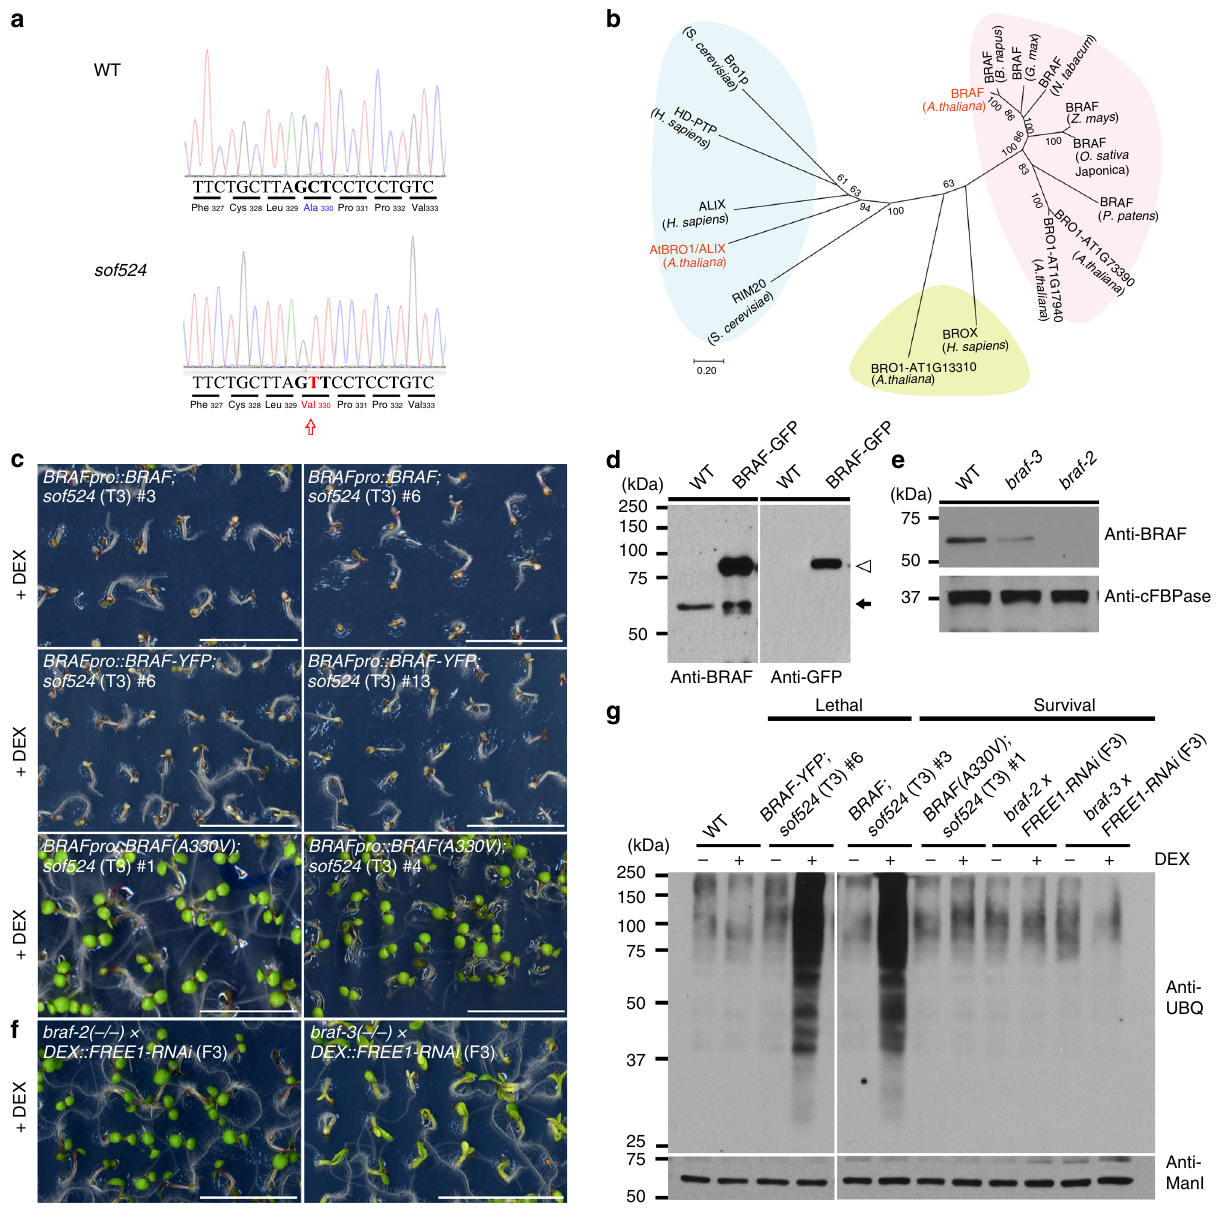
Fig. 2 The sof524 mutation affects BRAF. a Chromatograms of BRAF open reading frame sequence (Sanger sequencing of PCR-ampli fi ed DNA) from WT (top) or sof524 (bottom). Arrow indicates the identi fi ed nucleotide mutation (C-to-T transition), as well as the resulting amino-acid change (alanine 330 -to- valine) in NGS mapping analysis. b Neighbor-joining phylogenetic tree, generated with the amino-acid sequences of Bro1-domain-containing proteins, shows the predicted relationship of the Bro1-domain proteins in plants, yeast, and human. Major groupings are indicated by color codes. Note that AtBRO1/ ALIX and BRAF group separately. c Complementation of sof524 with BRAFpro::BRAF , BRAFpro::BRAF-YFP , or BRAFpro::BRAF(A330V) . The phenotype of 7- day-old sof524 seedling expressing indicated proteins growth on MS plates supplied with ( + ) DEX. Two transgenic lines are shown. Scale bar, 1 cm. d BRAF antibody can speci fi cally detect endogenous BRAF (arrow) and BRAF-GFP (arrowhead) fusion proteins. e BRAF expression analysis of T-DNA insertion mutants. Seven-day-old seedlings of indicated genotypes were subjected to immunoblot analysis with indicated antibodies. Anti-cFBPase is used as a loading control. f The phenotype of 7-day-old seedlings of double-homozygous mutants braf-2 ( − / − ) DEX::FREE1-RNAi and 10-day-old of braf-3 ( − / − ) DEX:: FREE1-RNAi growth on MS plates supplied with ( + ) DEX. Scale bar, 1 cm. g Immunoblot analysis with anti-UBQ on membrane protein extracts from the indicated seedlings of genotypes. Anti-ManI is used as a loading control BRAF colocalizes with FREE1 and interacts with Vps23 . To get braf-2 ( − / − ) free1 ( + / − ). The possible explanation for the difference might be due to the multiple function of the FREE1 insights on BRAF function in plants and how it functions with protein in different plant growth stages and suppressor screening FREE1, we fi rst analyzed the subcellular localization of BRAF. To using DEX::FREE1-RNAi as starting material focuses on the this aim, we used the Arabidopsis transgenic lines expressing FREE1 function in post-germination growth. All of these results GFP- or monomeric red fl uorescent protein (mRFP)-tagged suggested that BRAF speci fi cally converts the lethal phenotype of forms of BRAF, which fully colocalized at the PM and intracel- FREE1-RNAi plants. lular punctate dots (Supplementary Fig. 5A). BRAF-GFP showed NATURE COMMUNICATIONS| (2018) 9:3784 |DOI: